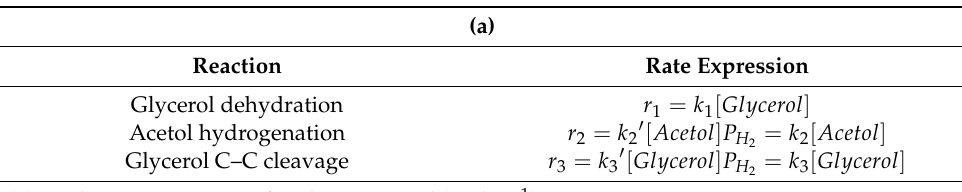
Scheme 1. Reaction pathway of glycerol hydrogenolysis. Table 2. ( a ) Rate expressions for the compounds in a glycerol hydrogenolysis process. ( b ) Mole balance equation for each